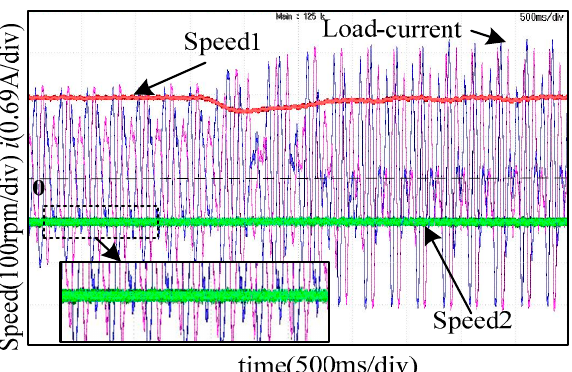
Figure 21. The current and speed waveform of speed closed − loop decoupling control with current compensation under further load step from 4 N·m to 6.5 N·m.